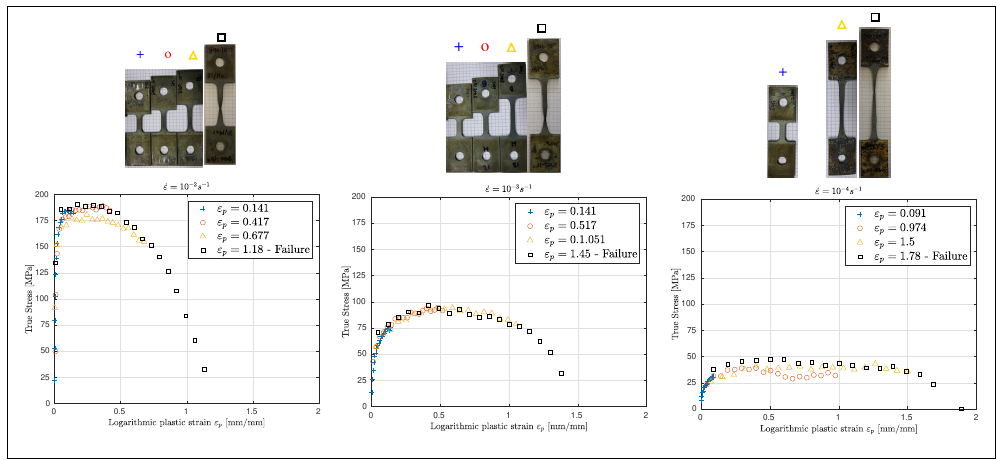
Figure 2. Plastic Stress-Strain curves performed at 840 ◦ C for several strain rate conditions and